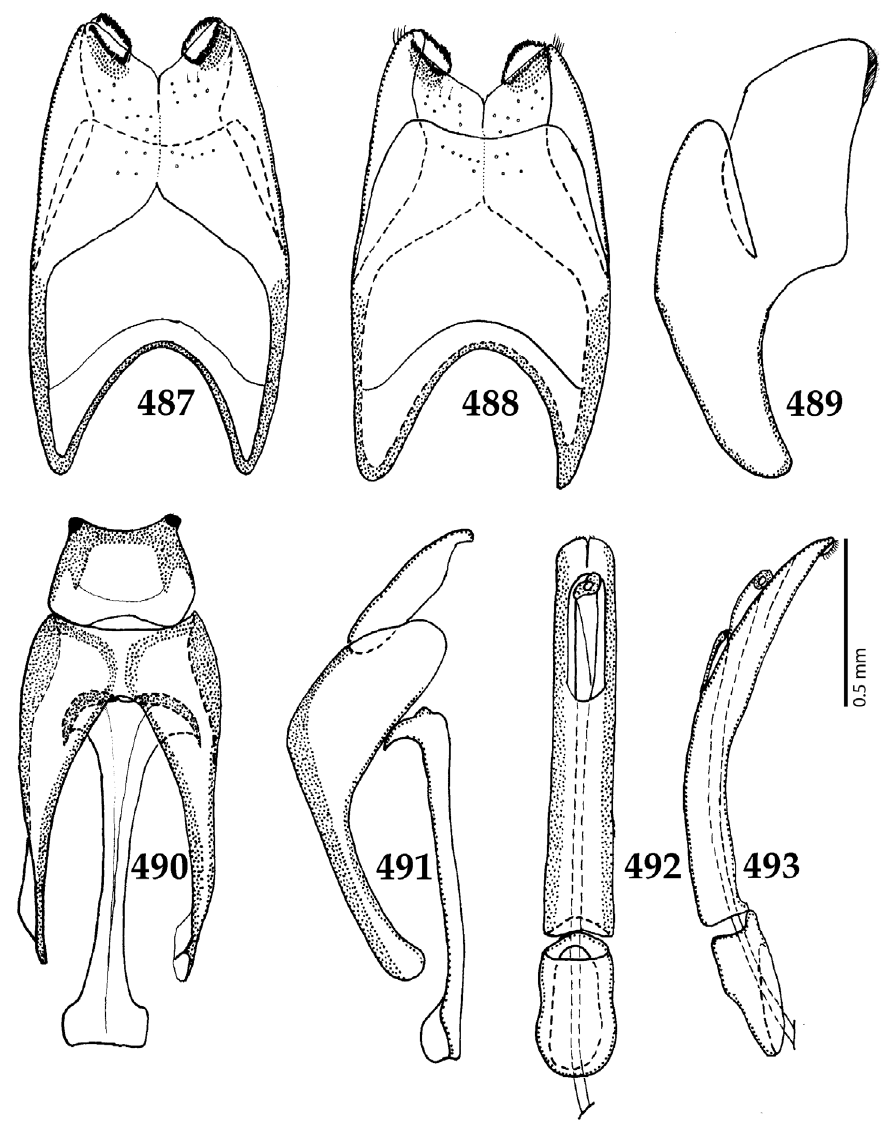
+ 8 th tergite, ventral view 488 ditto, dorsal view 489 ditto, lateral view 490 male terminalia: 9 th + 10 th tergites, dorsal view; spiculum gastrale, ventral view 491 male terminalia: 9 th + 10 th tergites; spiculum gastrale, lateral view 492 male terminalia: aedeagus, dorsal view 493 ditto, lateral